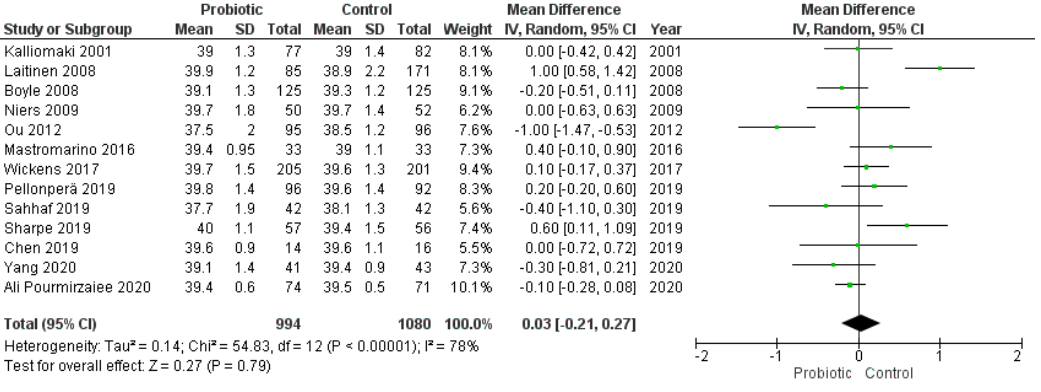
Figure 4. Meta-analysis of studies evaluating the administration of probiotic and weeks of gestation.